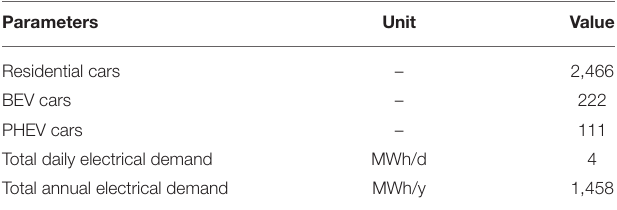
TABLE 4 | VSA estimated EV charging requirements for 2030.